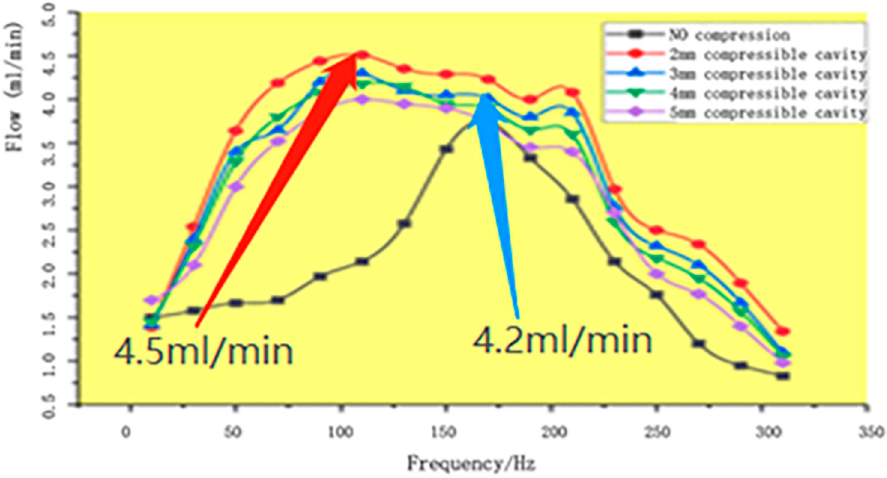
Figure 6. Frequency–flow rate comparison curves.